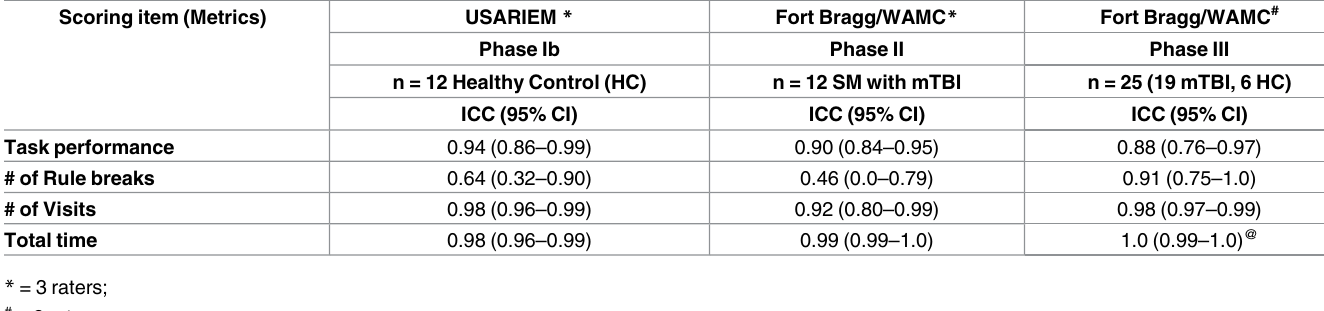
Table 7. Charge of Quarters (CQ) Duty